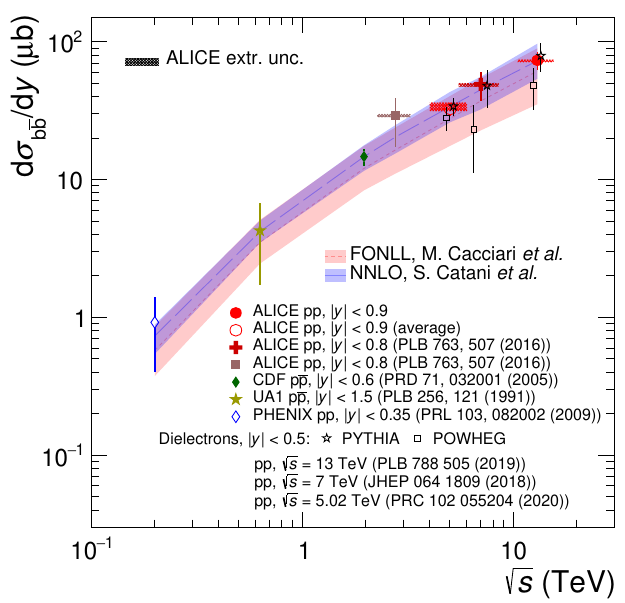
Figure 6 . The d σ / d y at midrapidity as a function of the centre-of-mass energy. The ALICE bb √ measurement at s = 5.02 TeV corresponds to the weighted average of non-prompt D mesons [96] and non-prompt J /ψ (see text for details). The ALICE results are compared with existing measure- ments in pp collisions (PHENIX [98] and ALICE [99]) and in p p collisions (UA1 [100] and CDF [1]). The shaded area around the ALICE data points represents the extrapolation uncertainty.